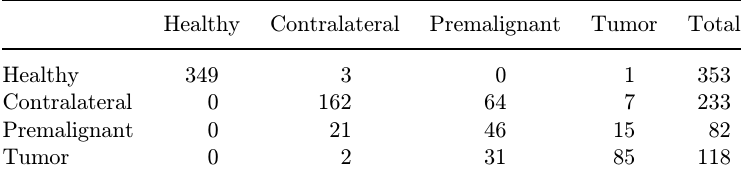
Table 6. PC-LDA for e±ciency of RS in identifying healthy, contralateral, premalignant and tumor conditions at buccal mucosa